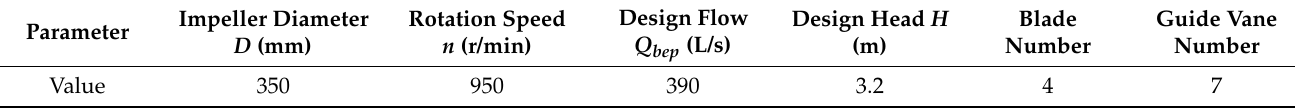
Table 1. The main design parameters of the pump